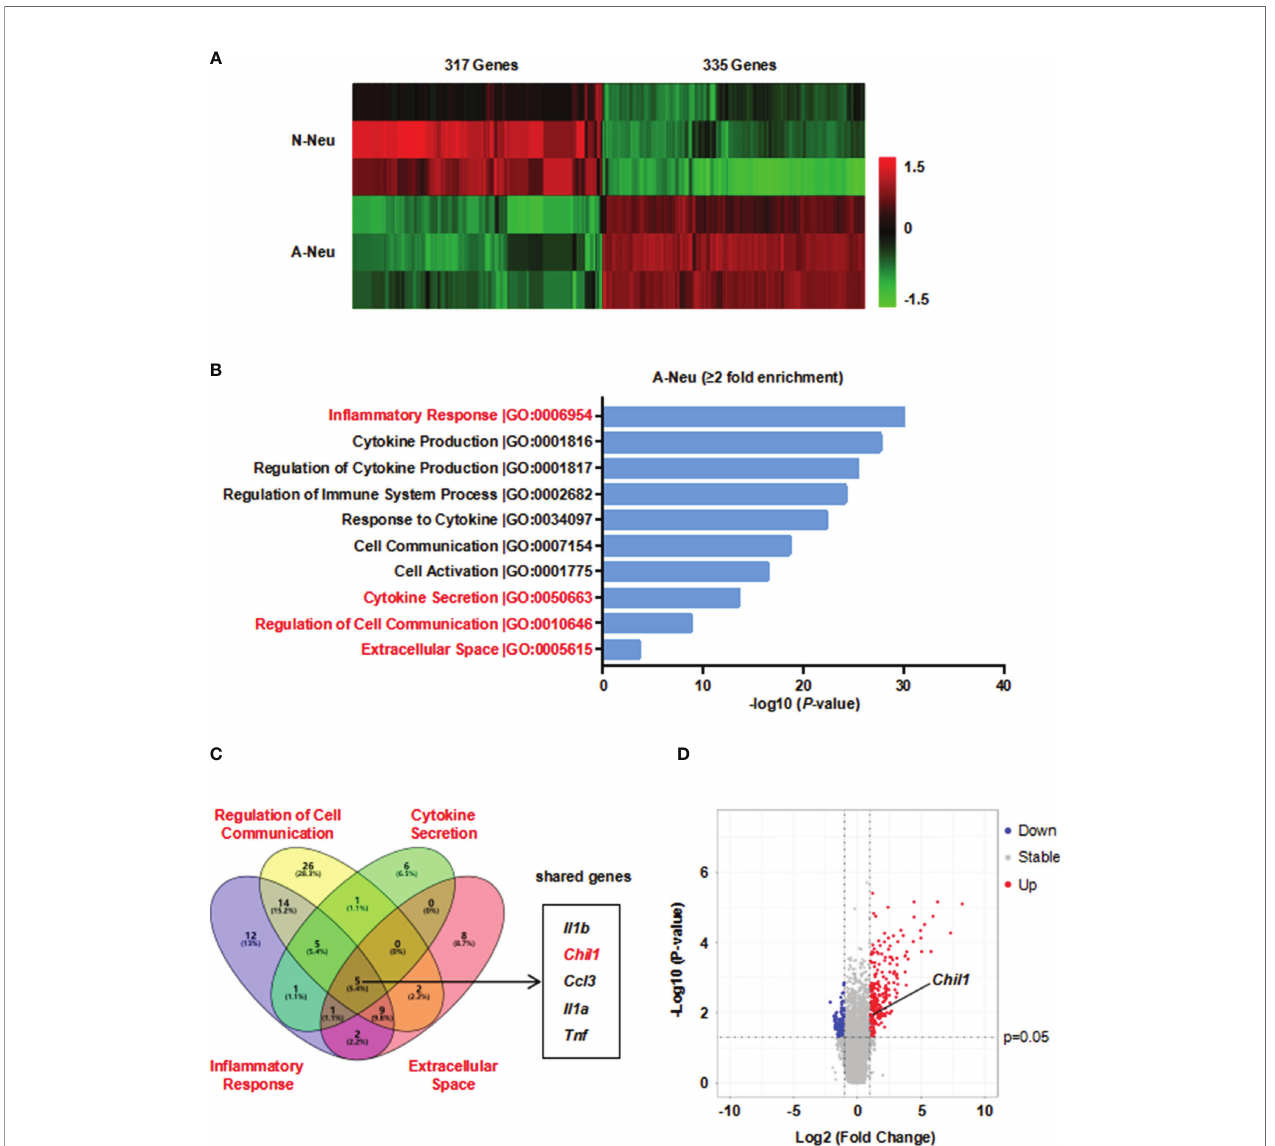
FIGURE 4 | Microarray analysis was performed in N-Neu and A-Neu. (A) Microarray heatmap data showing the expression level of transcript between N-Neu and A-Neu. The mRNA expressions were expressed as follows: Bright green, under expression; black, no change; bright red, overexpression. n=3. Row-based Z-score normalized. (B) GO enrichment analysis of differentially expressed genes in S1P activated neutrophils. (C) Venn diagram of gene expression overlap between GO terms including Regulation of Cell Communication, Cytokine Secretion, In fl ammatory Response and Extracellular Space clusters. (D) Volcano plot of A-Neu gene expression compared with N-Neu. The threshold values were fold change ≥ |2| and P value ≤ 0.05. Red dots and blue dots represent up-regulated and down-regulated genes, respectively. Gray dots indicate genes with no statistically signi fi cant differences. The arrow indicated the location of Chil1. A-Neu, activated neutrophil; N-Neu, non-activated neutrophil; Il1b, Interleukin 1 beta; Chil1, Chitinase-like 1; Ccl3, Chemokine (C-C motif) ligand 3; Il1a, Interleukin 1 alpha; Tnf, tumor necrosis